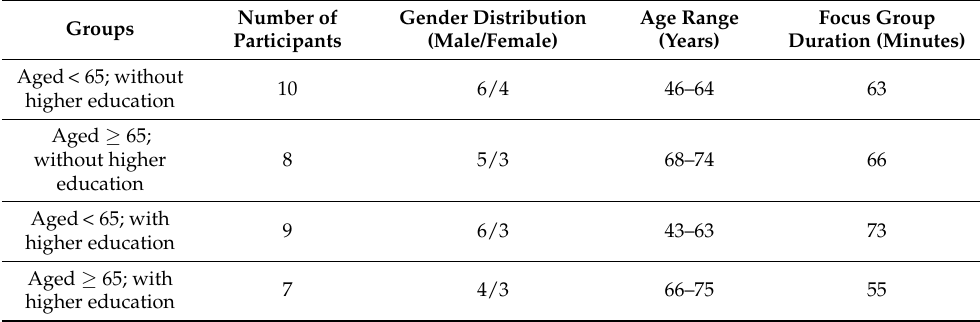
Table 1. Focus groups